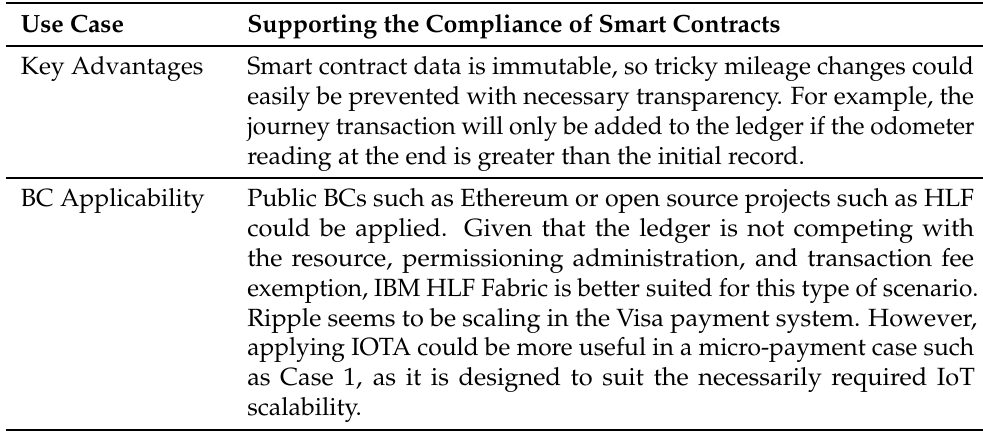
Table 6. Key advantages and BC applicability for the supporting smart contract compliance use